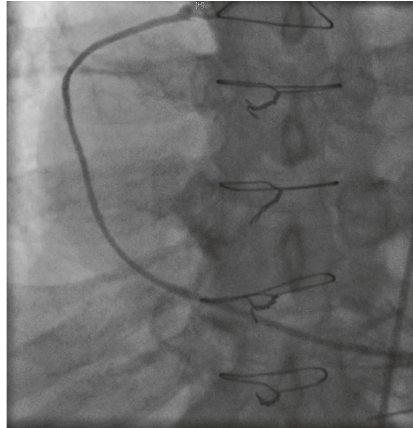
Figure 4: Patent saphenous venous graft to posterior descending